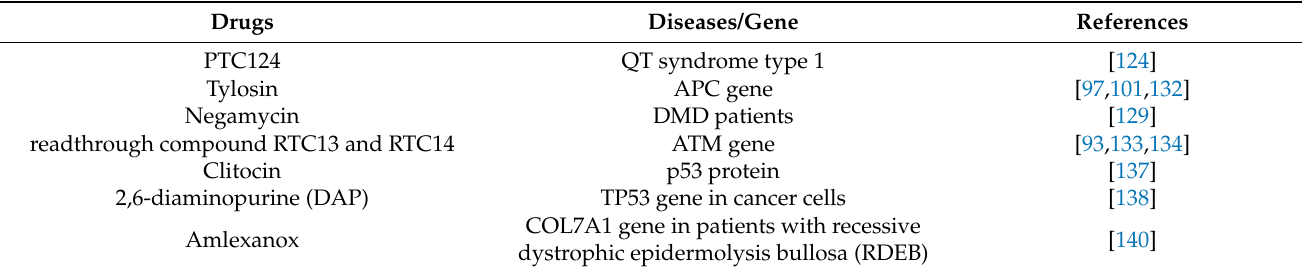
Table 2. Non-aminoglycoside drugs that induce readthrough.